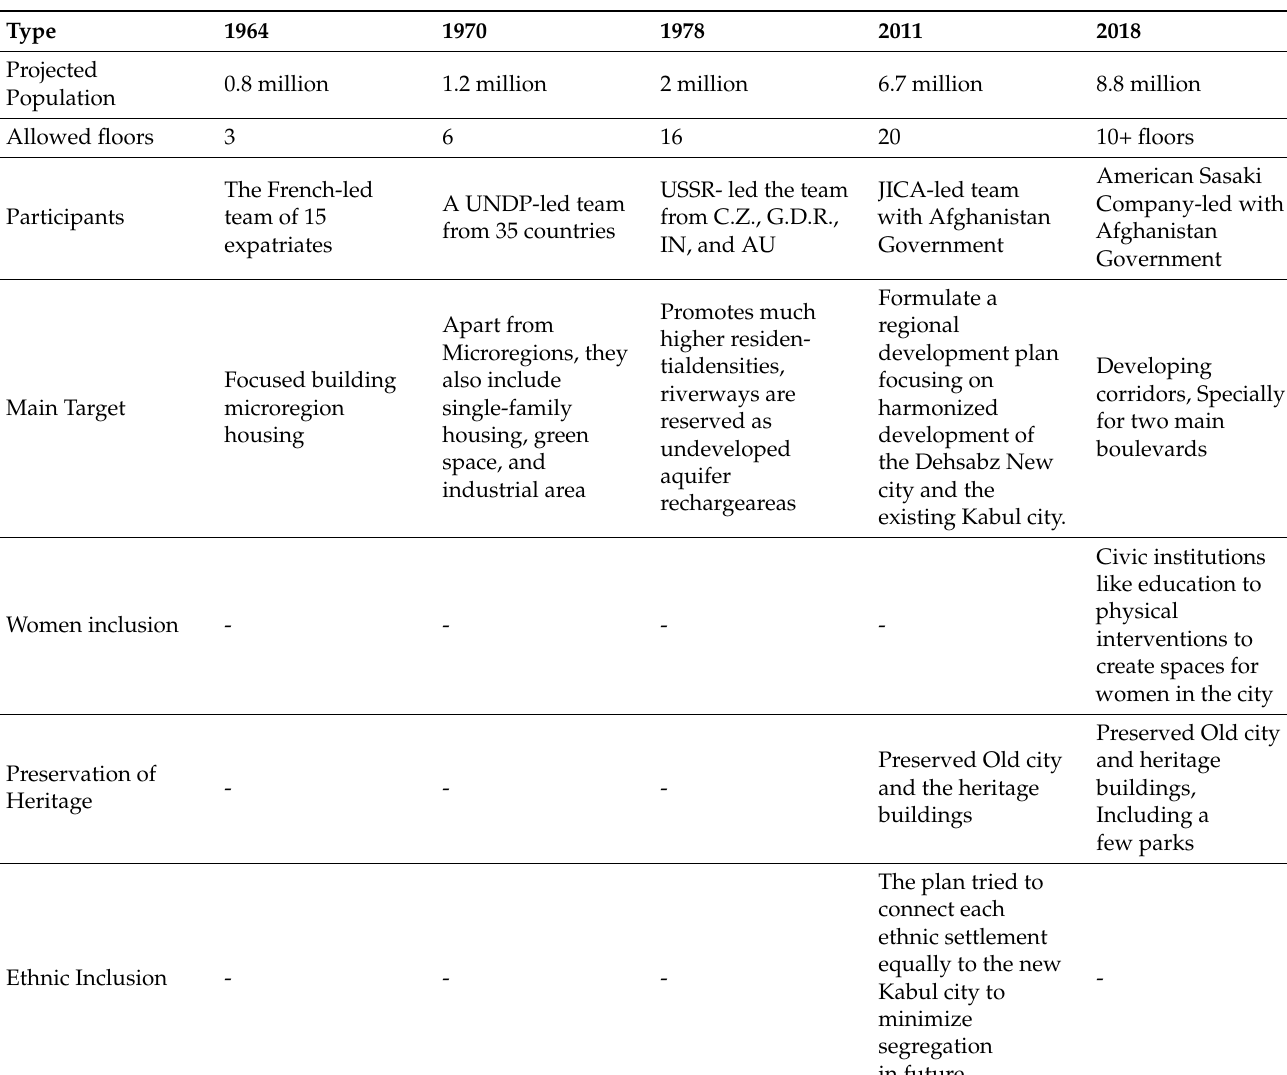
Table 1. Master plans of